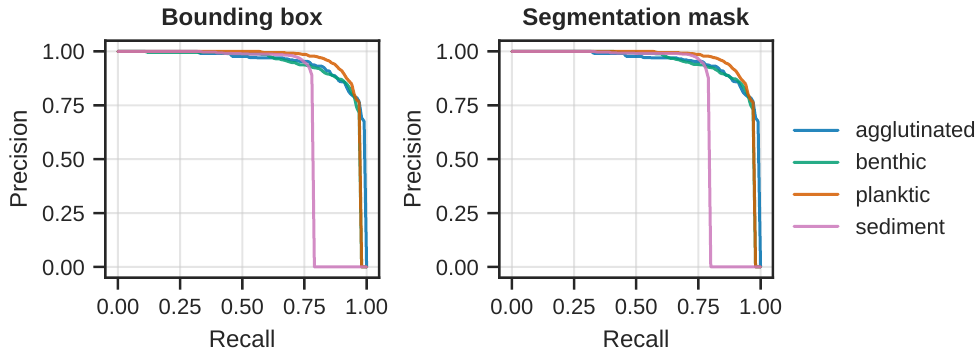
Figure 8. Precision-recall curves for each of the four object classes. ( Left ): Per-class curves for the detection (bounding box) task. Performance is approximately the same for the “agglutinated”, “benthic”, and “planktic” classes, but it is significantly worse for the “sediment” class. ( Right ): The per-class curves for the segmentation task, which tells the same story as for the detection